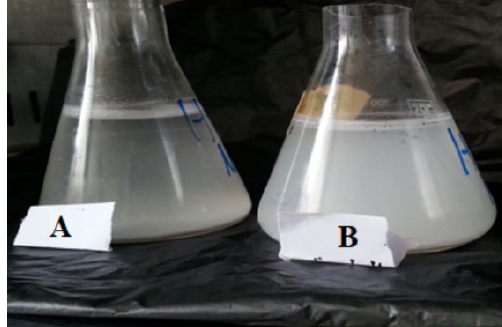
Fig. 9. Bio-flocculant activity by Streptomyces mutabilis M3 MT483919 extract. The sample after treatment (A) and before treatment (control) (B)